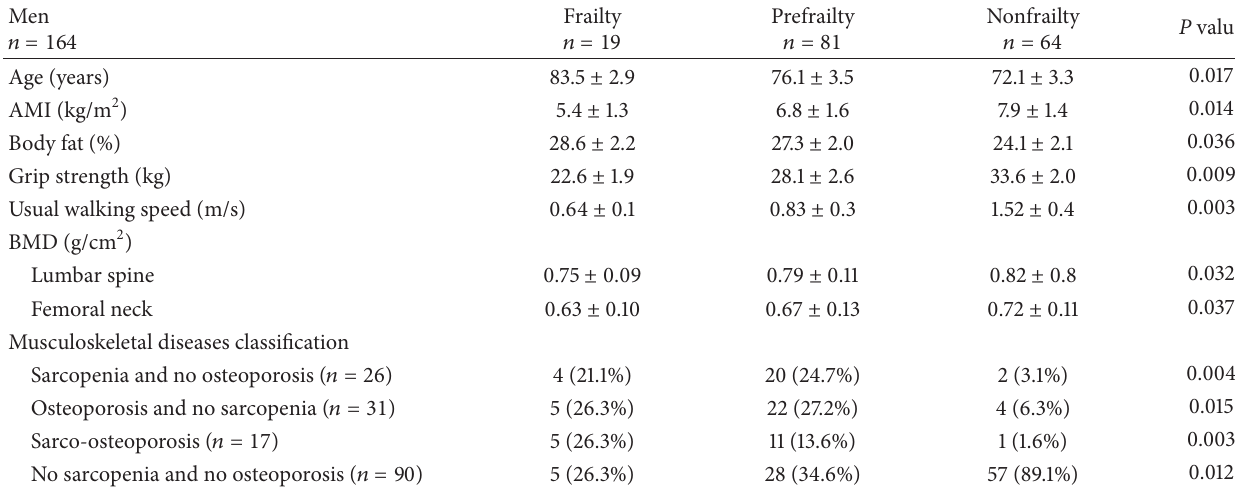
Table 4: Characteristics of men by presence of